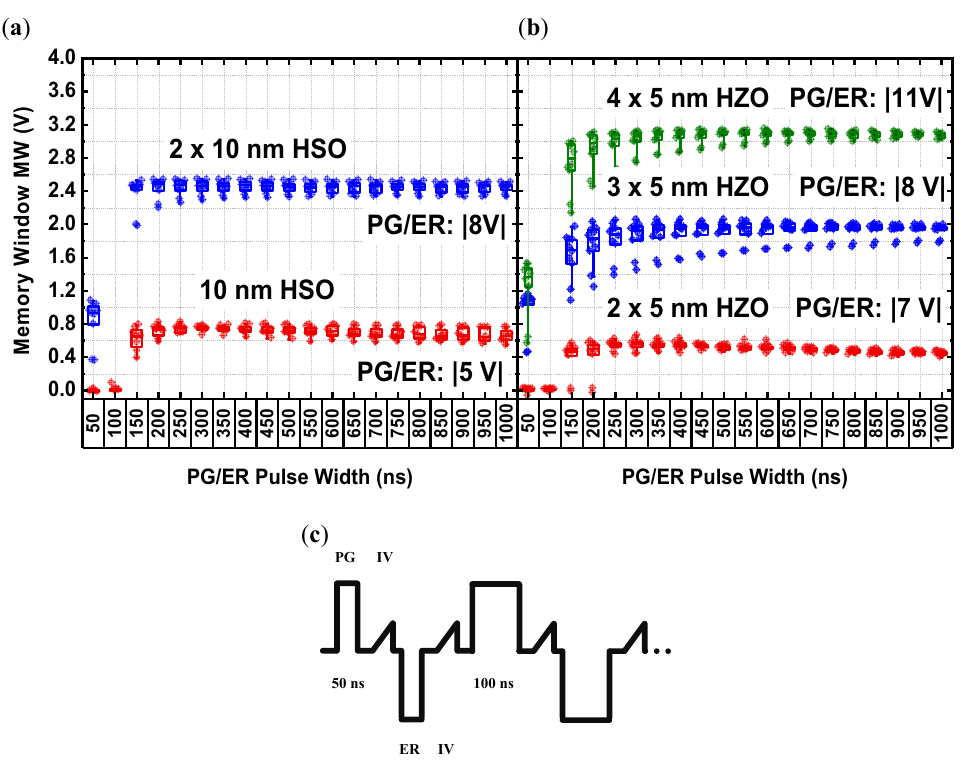
Figure 11. The MW dependence on the write pulse width for ( a ) the HSO and ( b ) the HZO ferroelectric laminate stack shows a saturated maximum of the MW at each ferroelectric stack thickness, ( c ) the measurement test sequence for the MW dependence on the pulse width. Reproduced with permission from [17] T. Ali et al., IEDM; published by IEEE, Copyright 2019, IEEE.